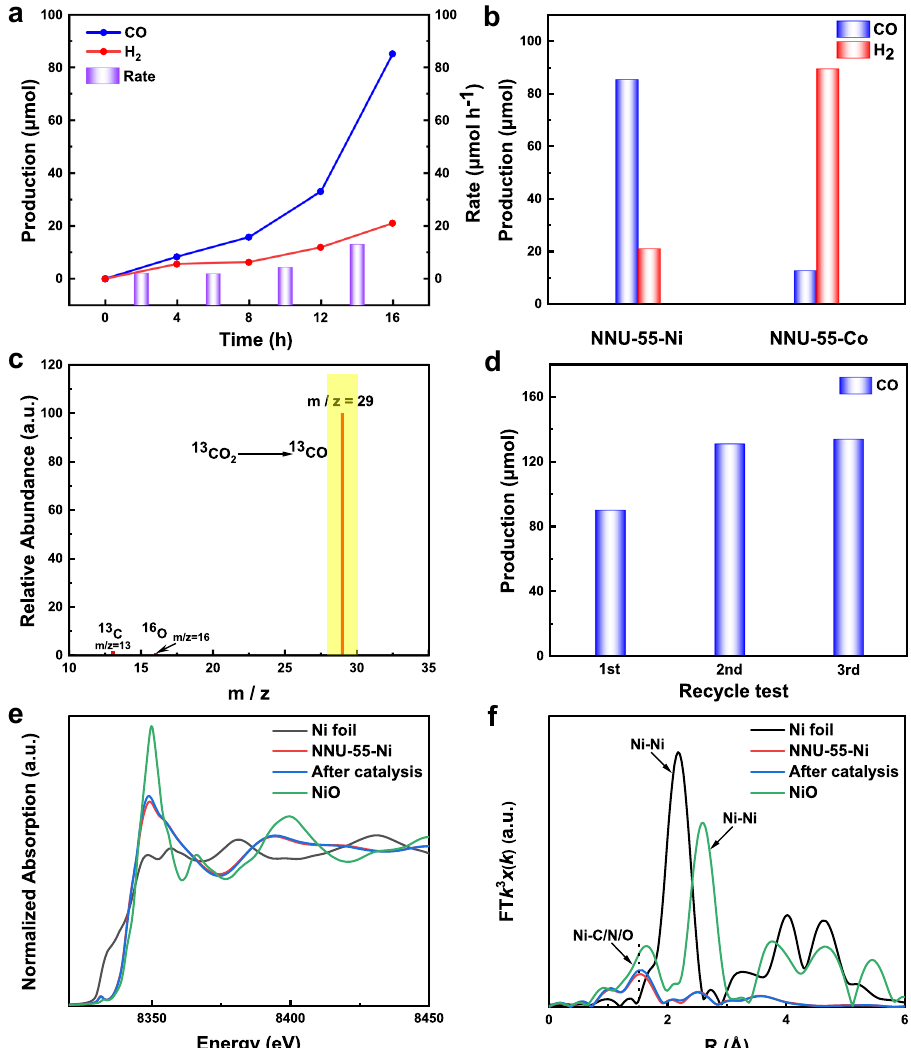
Fig. 3 Photocatalytic performances of NNU-55-M. a A function of the irradiation time of CO and H 2 production from CO 2 photoreduction over NNU-55- Ni. The purple cylinder represents the reaction rate every 4 h. b The amount of CO and H 2 produced with NNU-55-M. c Mass spectra ( m / z = 29) analysis for reduction product 13 CO (yellow shaded regions) under 13 CO 2 atmosphere. d The recycle experiments were conducted to NNU-55-Ni. e The experimental Ni K-edge XANES spectra of NNU-55-Ni samples before and after photocatalytic CO 2 RR as compared with calibrated standard Ni foil